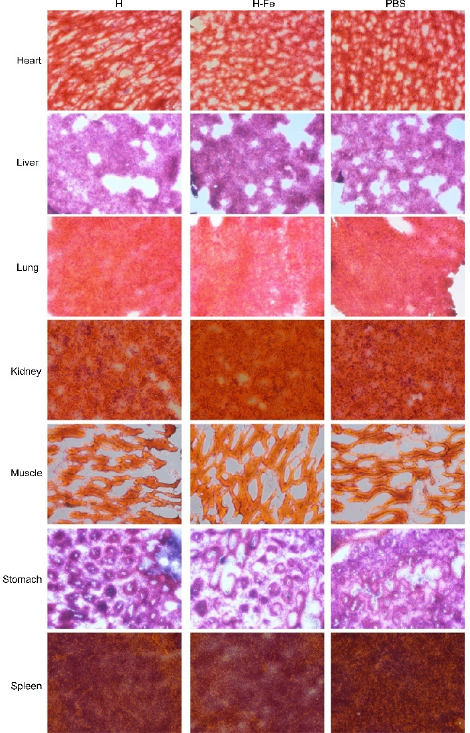
Figure 4. HE-stained sections of mice after immunization with antigens expressed in silkworms. The heart, liver, lung, kidney, muscle, stomach and spleen tissues were tested. The scale bar is 100 µ m. 3.6. Detection of Antibody Titers in Serum of Mice Immunized with H-Fe and H Antigen